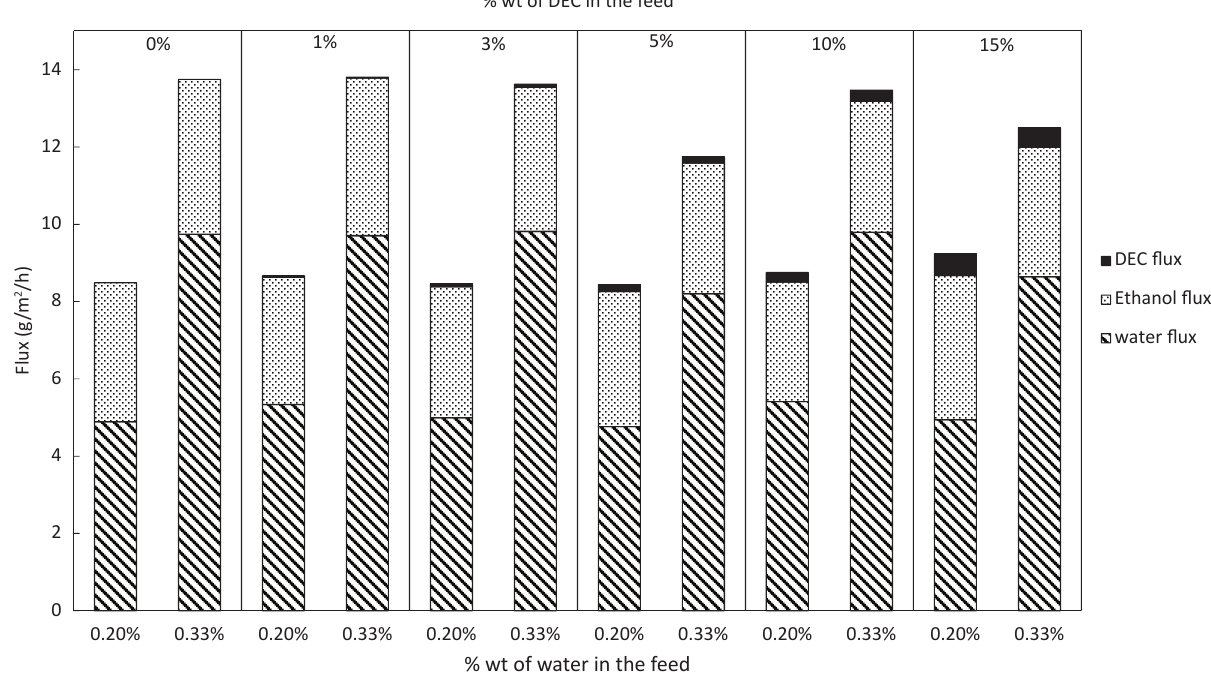
Figure 10: Partial flux of water, ethanol and DEC in function of the amount of water and DEC in the feed.